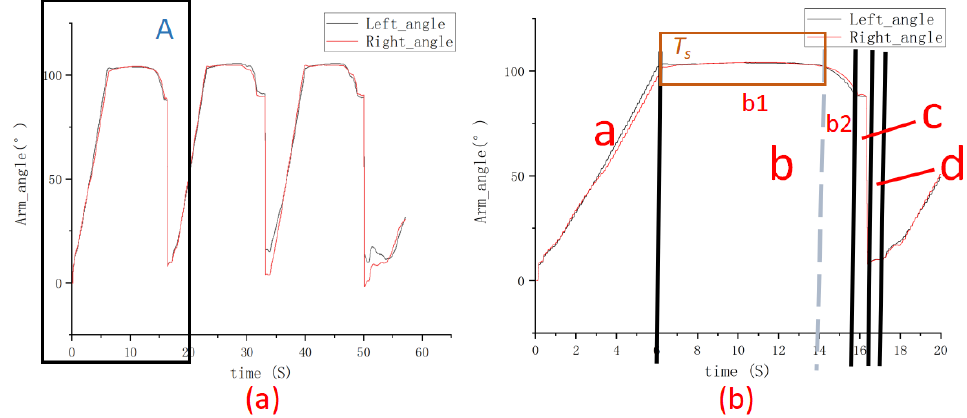
Figure 17. Cantilever vertical inclination curve of robot stair climbing test: ( a ) the robot climbs the stairs for 57 s; ( b ) the amplification diagram of part A in figure ( a ).